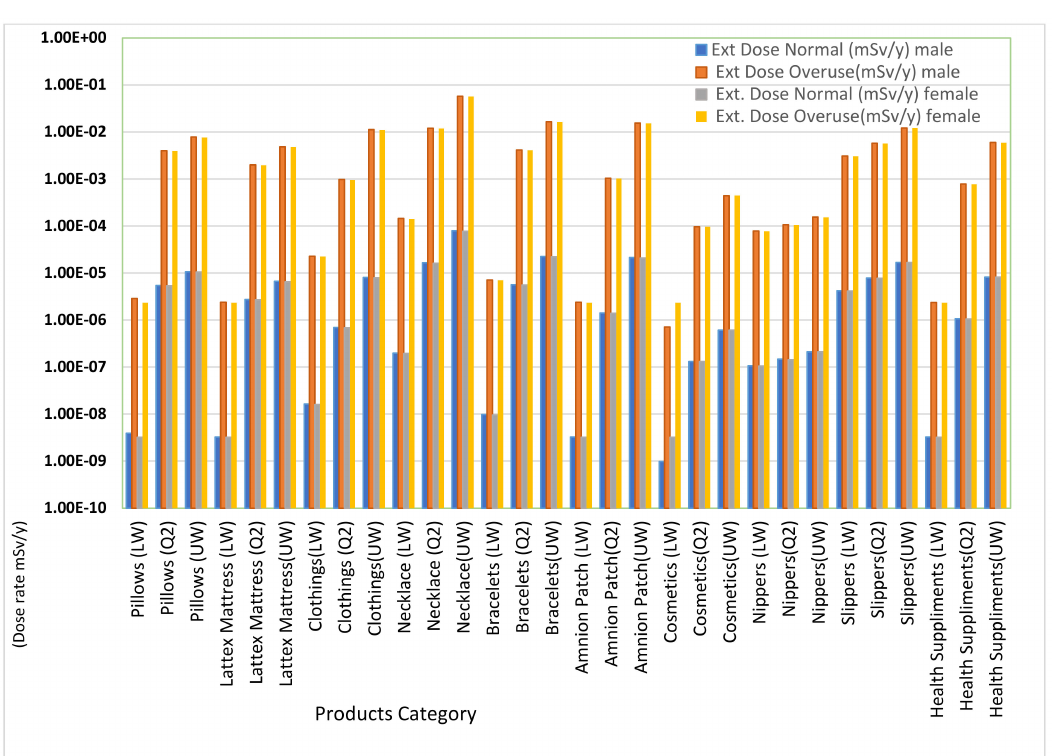
Figure 5. External dose during normal use and overuse for both phantoms using